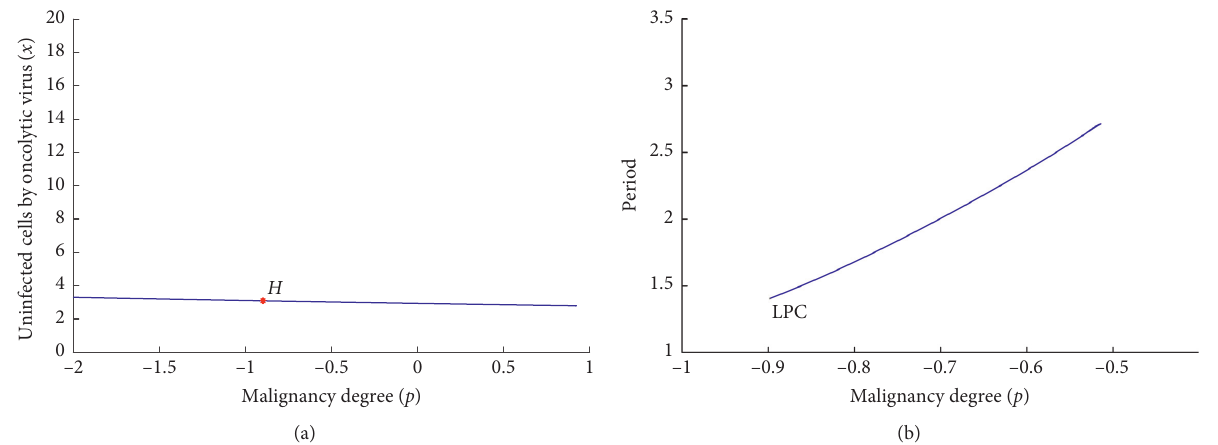
Figure 1: (a) Hopf point for the variation of parameter p . (b) Continuation of the periodic solution created by the Hopf bifurcation. The first Lyapunov exponent of the Hopf bifurcation is 3 . 37967 × 10 − 4